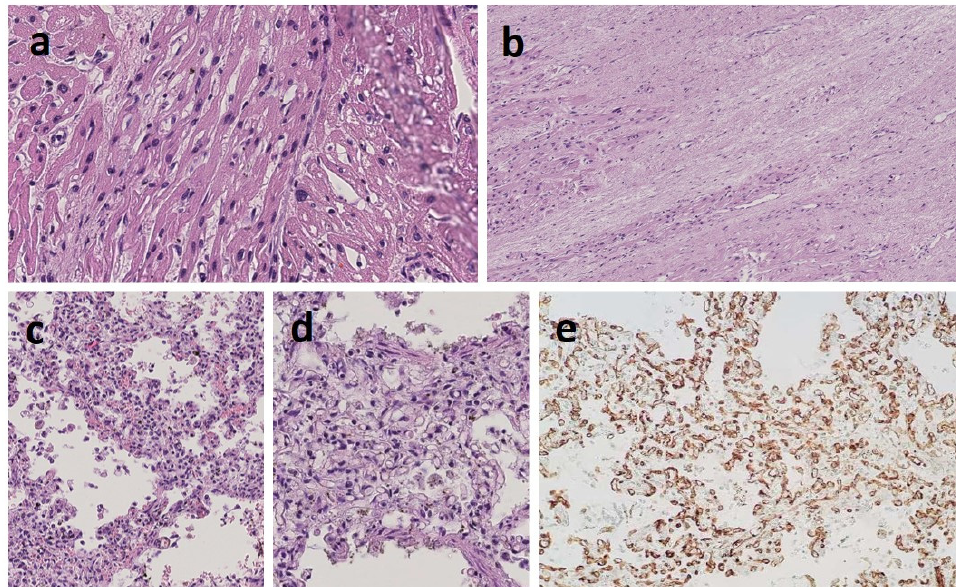
Figure 4. Histology showed a complete disarray of both gross and fine cardiac and pulmonary anatomy. Heart microscopy showed disorientation of muscle fibers and hypertrophic myocells with enlarged ovoid nucleus ( a ), left ventricle fibrotic and necrotic areas of myocells (long-standing infarction) and limited neighboring areas of more recent ischemic damage ( b ). Picture of the lungs with arterial hypertension, chronic stasis and alveolar damage: pulmonary capillary hemangiomatosis with peripheral arterioles with stenotic lumen for muscular tunic hypertrophy, intimal tunic thickening, hilar pulmonary vessels of increased caliber and with hypertrophic wall, thickened and hypervascularized interalveolar septa, alveolar lumens with exudate and foamy histiocytes containing hemosiderin ( c ), and increased thickness of the interalveolar septum with hypercapillarization ( d ). The capillaries (colored in brown with immunohistochemical staining CD31) were markedly in- creased in with a chaotic distribution (hemangiomatosis) with most of them not reaching the alveolar surface ( e ).